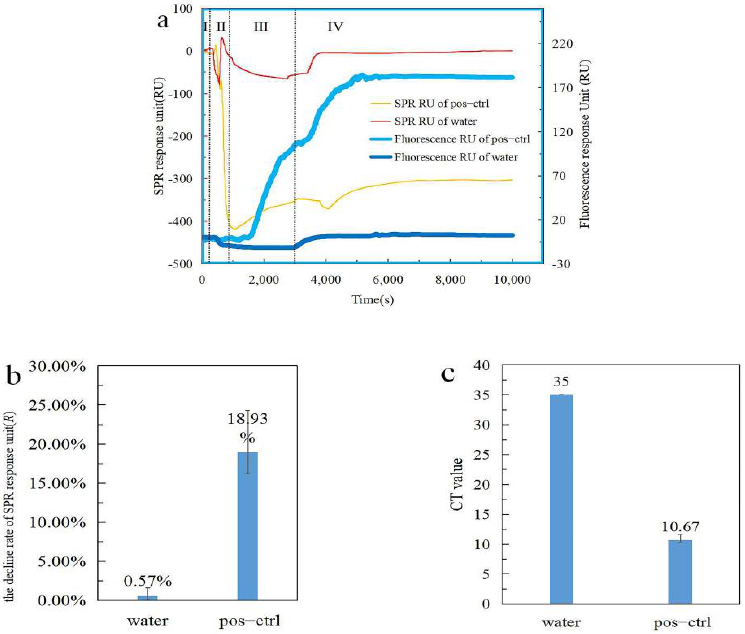
Figure 5. The results of simultaneous fluorescence and SPR detection in the integrated device are shown in this figure, ( b , c ) show the results of three replicates. The volume of positive control in this experiment was 2 µ L. ( a ) The results of SPR and fluorescence response unit of water and positive control during the LAMP process; the left ordinate in this figure is the SPR response unit, and the right is the fluorescence response unit. Region I of the figure shows the process of detecting the baseline, region II is the pre − warming part, region III is the amplification part, and region IV is the process of cooling to room temperature after the amplification is completed. ( b ) The decline rate of SPR response unit of water and positive control. ( c ) CT values of fluorescence detection (because water has no fluorescence response unit, it is assumed that its CT value is 35).